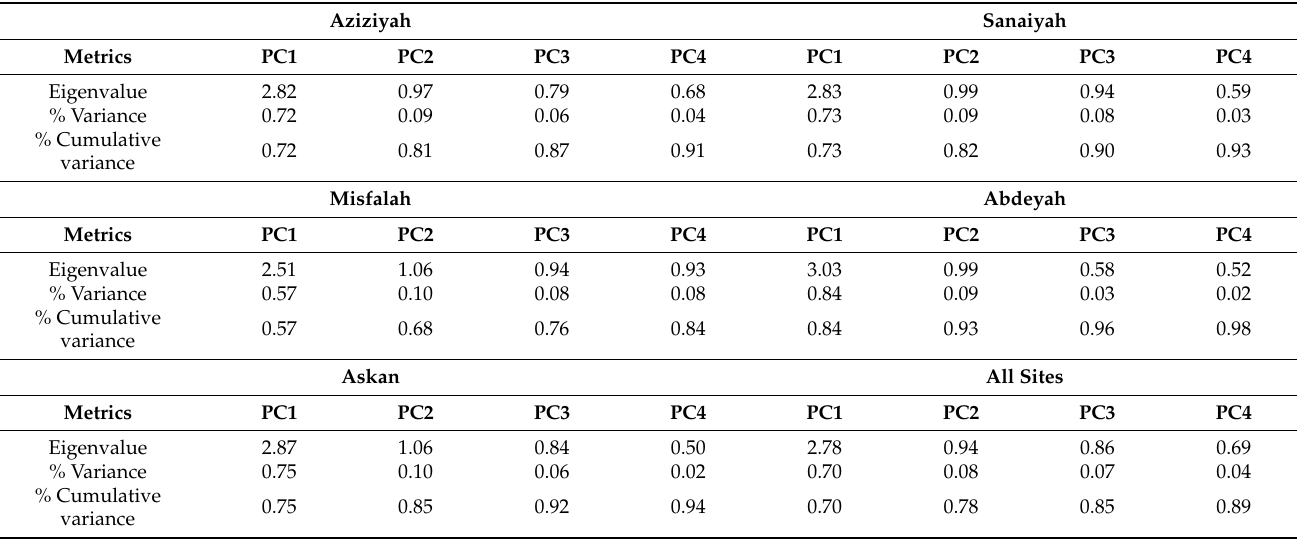
Table 3. Principal components and relevant metrics (Eigenvalue, % variance, and % cumulative variance) of each